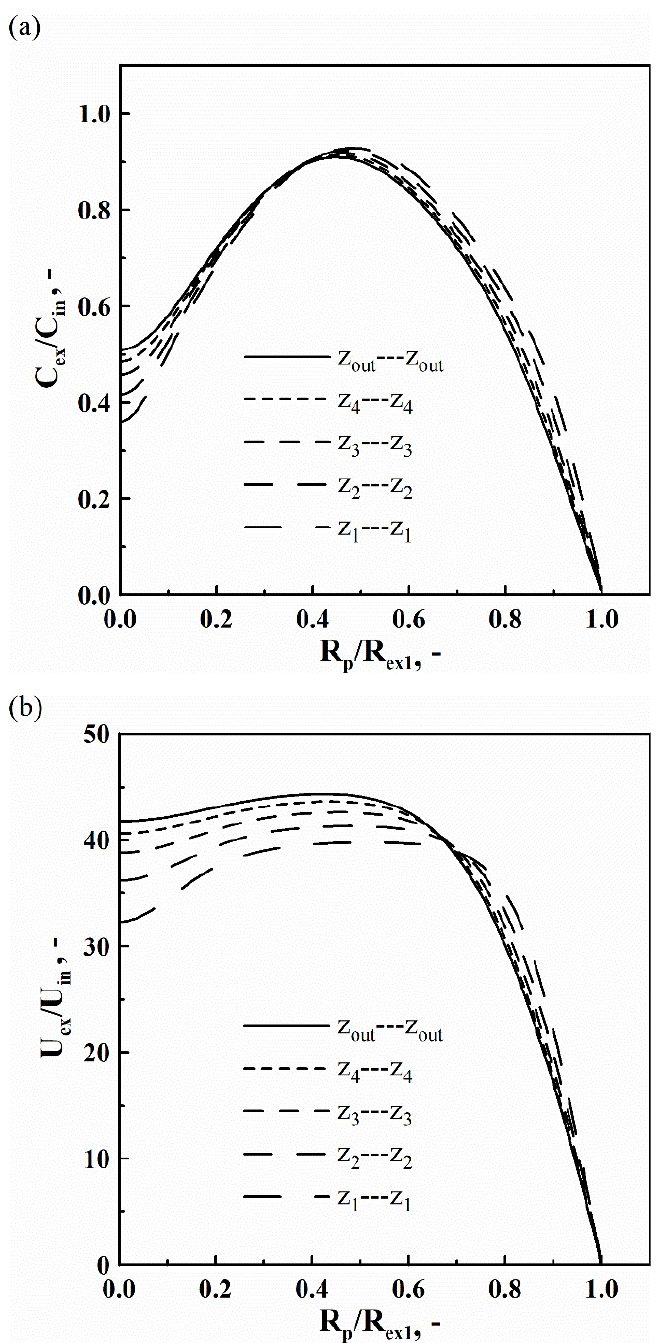
Figure 6. ( a ) Concentration and ( b ) velocity profile of z—z cross sections at different positions of the hollow tapered cylinder with the conical column for the particle diameters of 3 nm at the flow rate of 2 L/min.